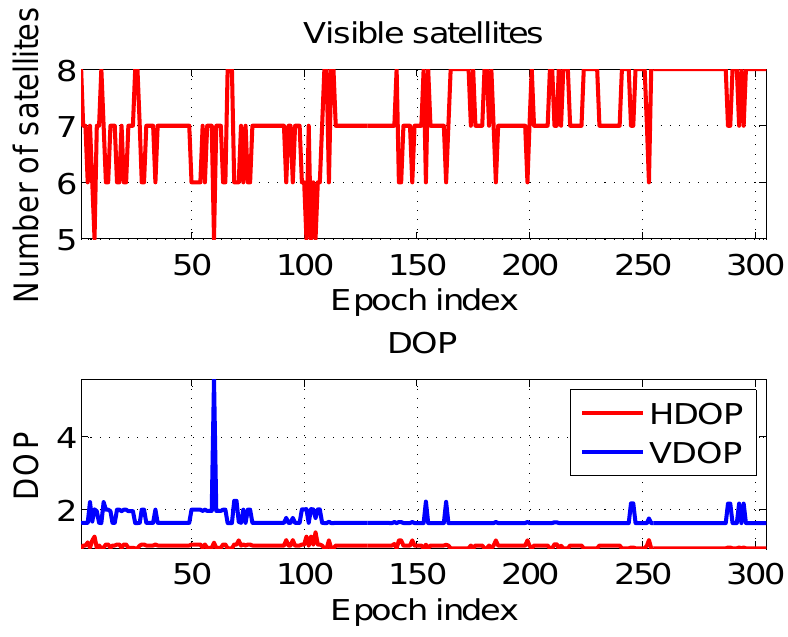
Figure 9. Number of visible satellites and DOPs recorded during the test conducted in the meeting